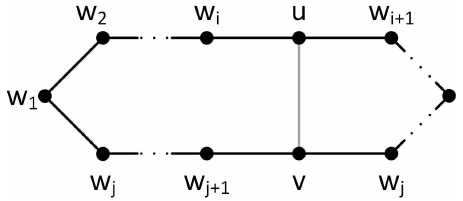
Figure 9. Chording a